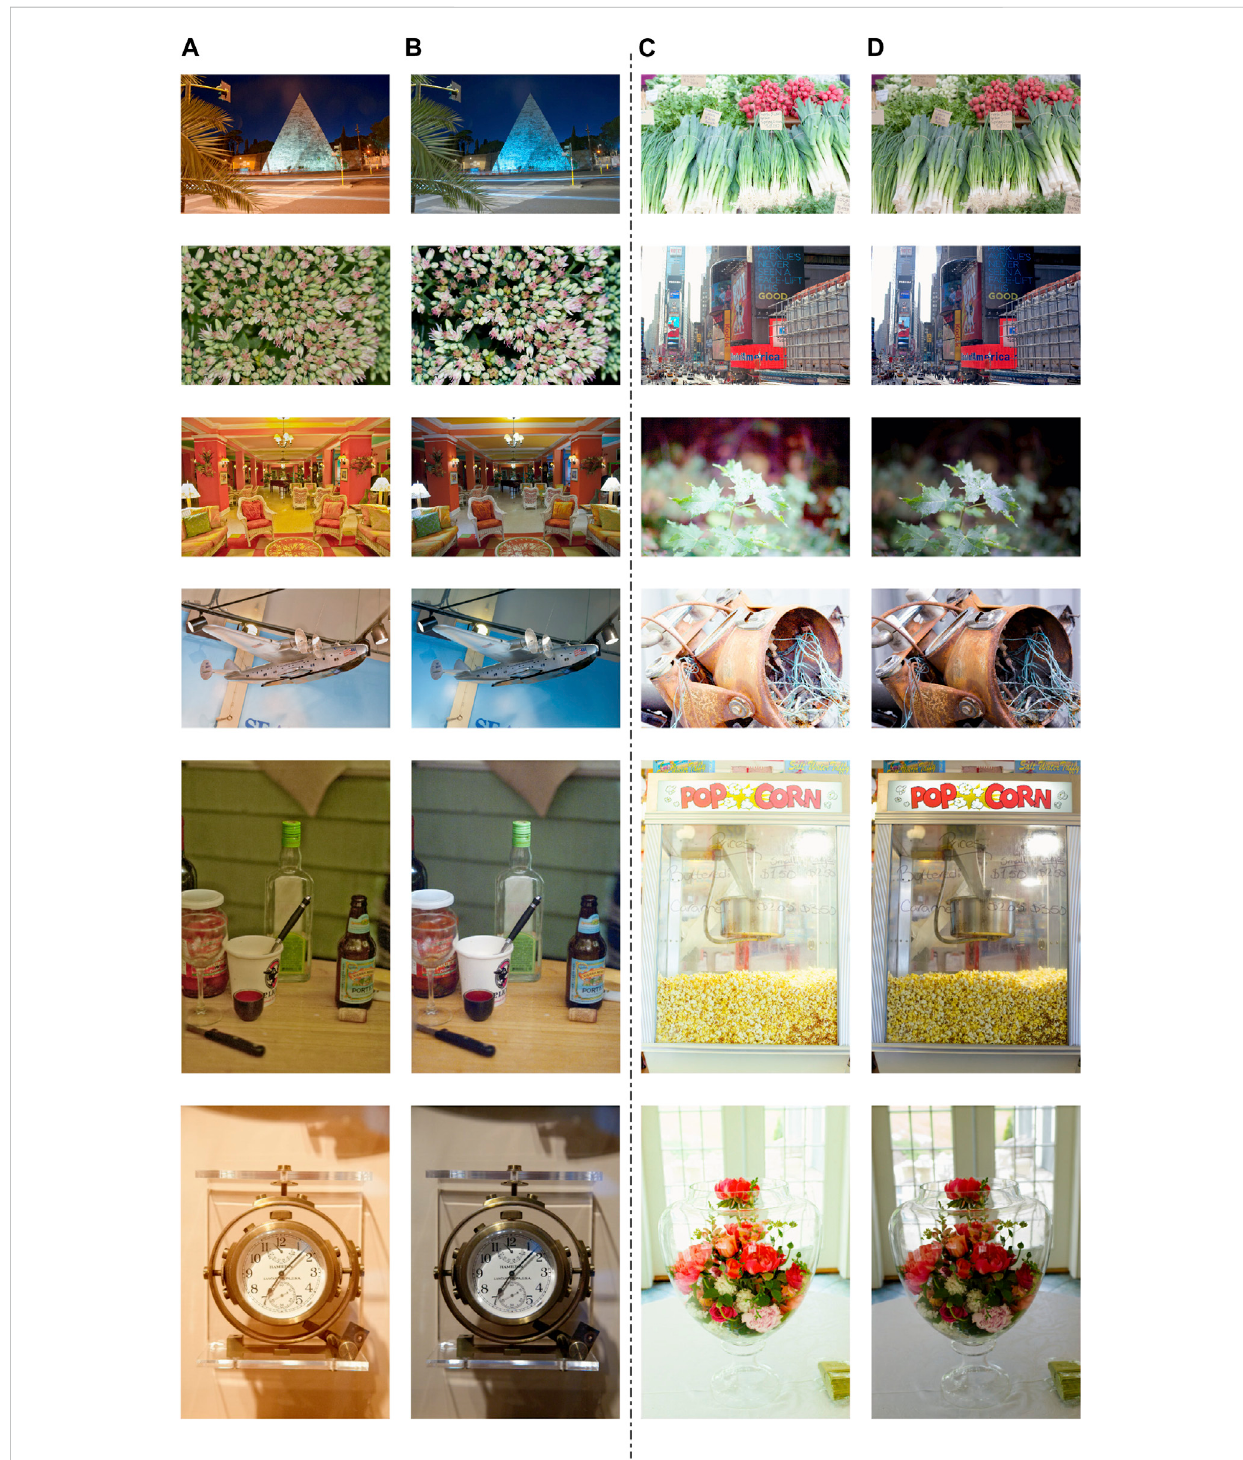
FIGURE 5 Qualitative comparison oftheenhancementresults of DarkeningNetworktrained with GTLL-NLpairs x r , y r (cid:7) (cid:8) andpseudo-LL-NLpairs x g , y r (cid:7) (cid:8) . (A,C) shows the enhanced results by GT LL-NL pairs x r , y r (cid:7) (cid:8) , (B,D) shows the enhanced results by pseudo-LL-NL pairs x g , y r (cid:7) (cid:8) . The proposed Darkening Network performs better by retaining semantically dark regions and correct white